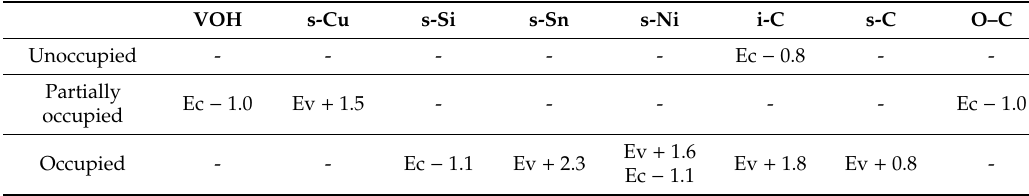
Table 2. Energy positions (eV) of deep levels introduced by impurities.